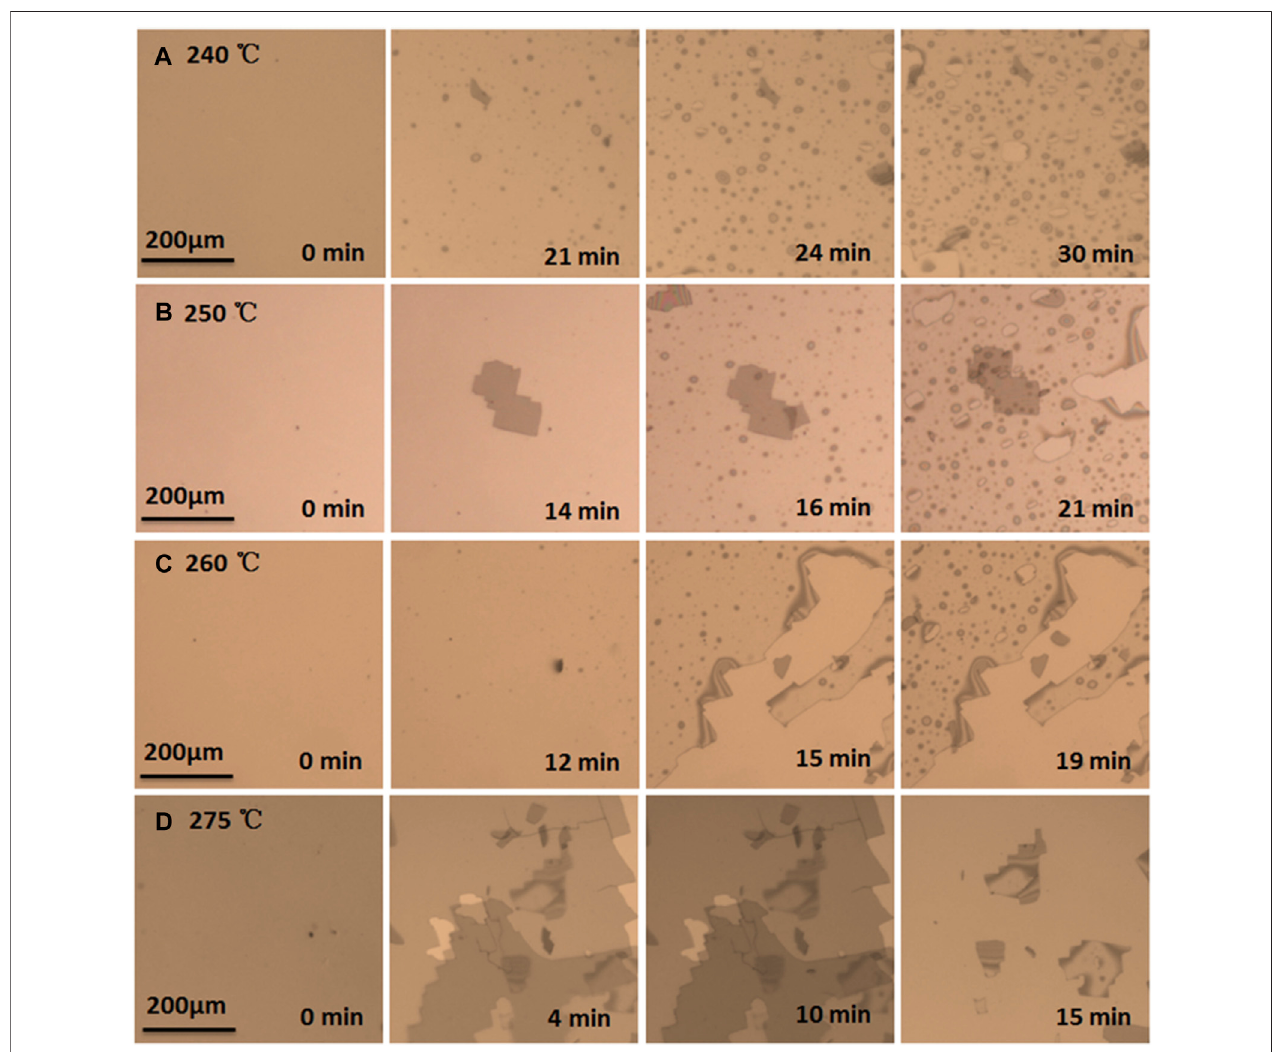
FIGURE 3 | Surface blistering of 128 ° Y – X LN implanted with a dose of 4.0 × 10 16 ions cm − 2 annealed at (A) 240 ° C, (B) 250 ° C, (C) 260 ° C, and (D) 275 ° C.